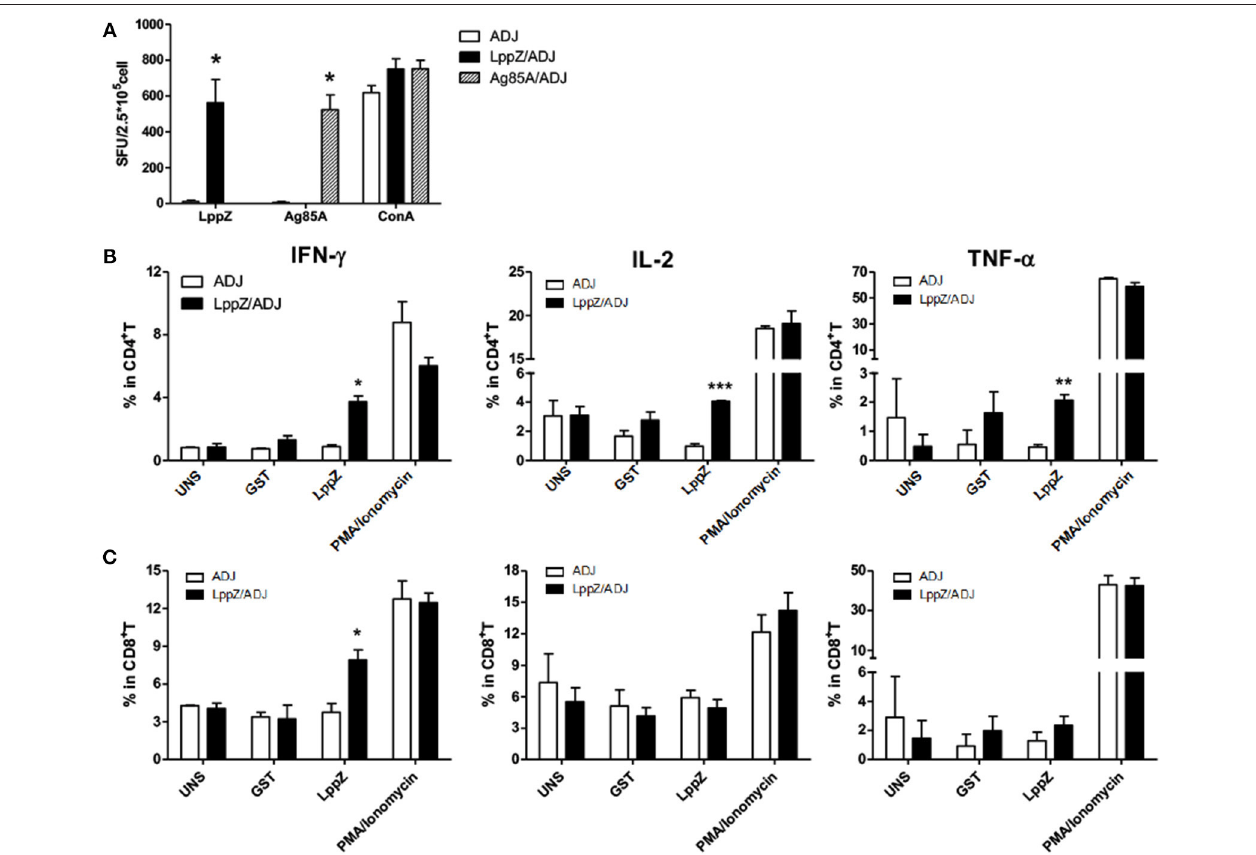
FIGURE 3 | LppZ evokes increased IFN- γ and TNF- α release from splenocytes of immunized mice. (A) C57BL/6 female mice (6–8 weeks old) were immunized with LppZ (LppZ/ADJ) or Ag85A (Ag85A/ADJ) recombinant proteins emulsified with adjuvant, or adjuvant only (ADJ). Splenocytes from different immunization group were collected. For ex vivo stimulation, 2.5 × 10 5 cells were incubated with LppZ (10 µ g/mL) or Ag85A (10 µ g/mL) for 20h. Antigen-specific IFN- γ -producing cells were measured by ELISpot assay. ConA was treated as a positive control. (B,C) 5 × 10 5 cells were incubated with LppZ (10 µ g/mL) for 20h. Antigen-specific IFN- γ , TNF- α , and IL-2 producing CD4 + (B) or CD8 + (C) T cells from the ADJ or LppZ/ADJ group were measured by flow cytometry. PMA/Ionomycin was a positive control and GST was an irrelevant control. UNS: without ex vivo antigen stimulation. * p < 0.05, ** p < 0.01, *** p <